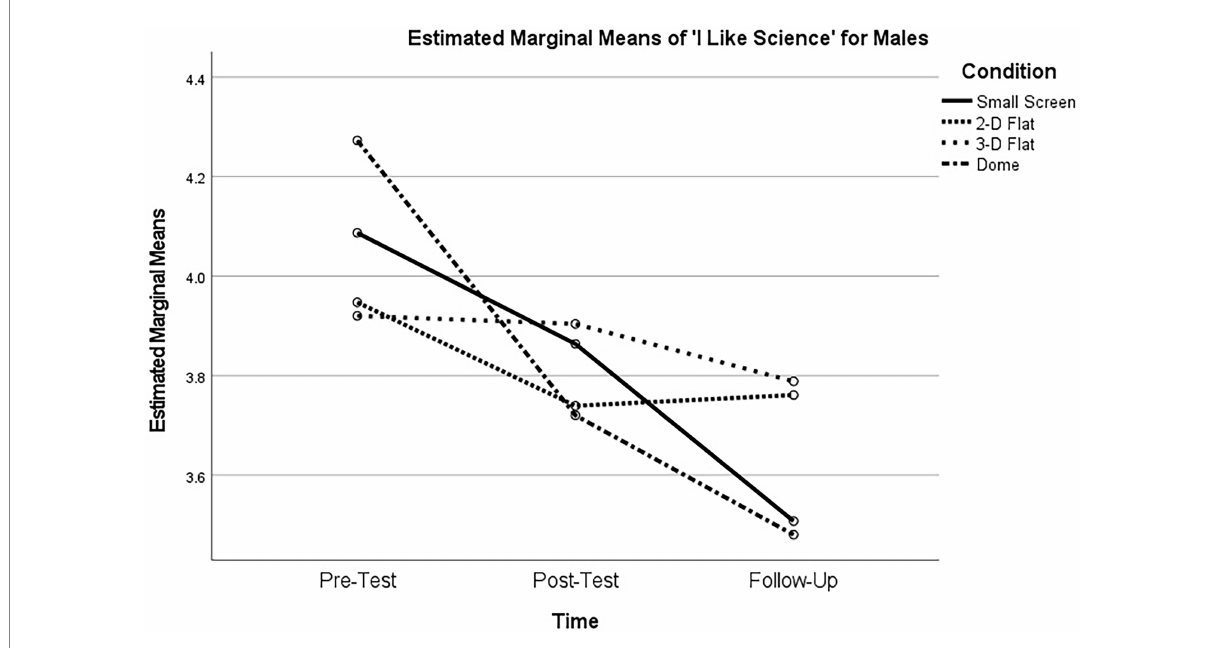
FIGURE 7 “I like science” performance for the males only.